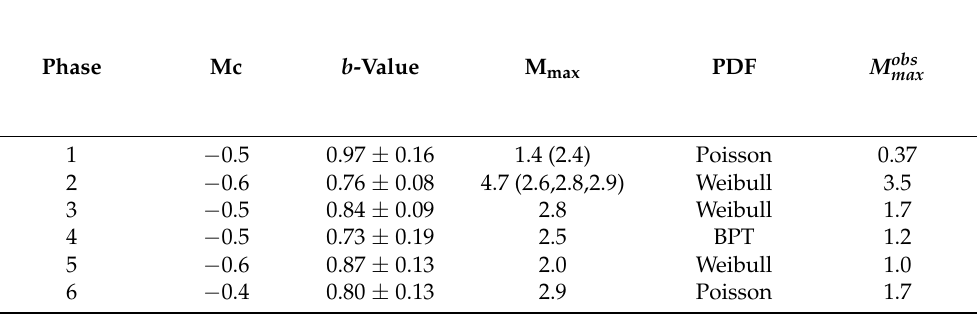
Table 2. Minimum magnitude of completeness (Mc), b-value, maximum magnitude and the best fit PDF for the analyzed periods. Concerning M max the values in parenthesis are obtained by using the approach proposed by McGarr [15]. For the second period, we report three different estimates since two distinct operations were done involving 290 m 3 and 700 m 3 of injected fluids, respectively. The first number in parenthesis is the magnitude corresponding to the first volume 290 m 3 , the second to the 700 m 3 volume, and the third to sum of the volumes (990 m 3 ). M obs max corresponds to the observed maximum magnitude in each